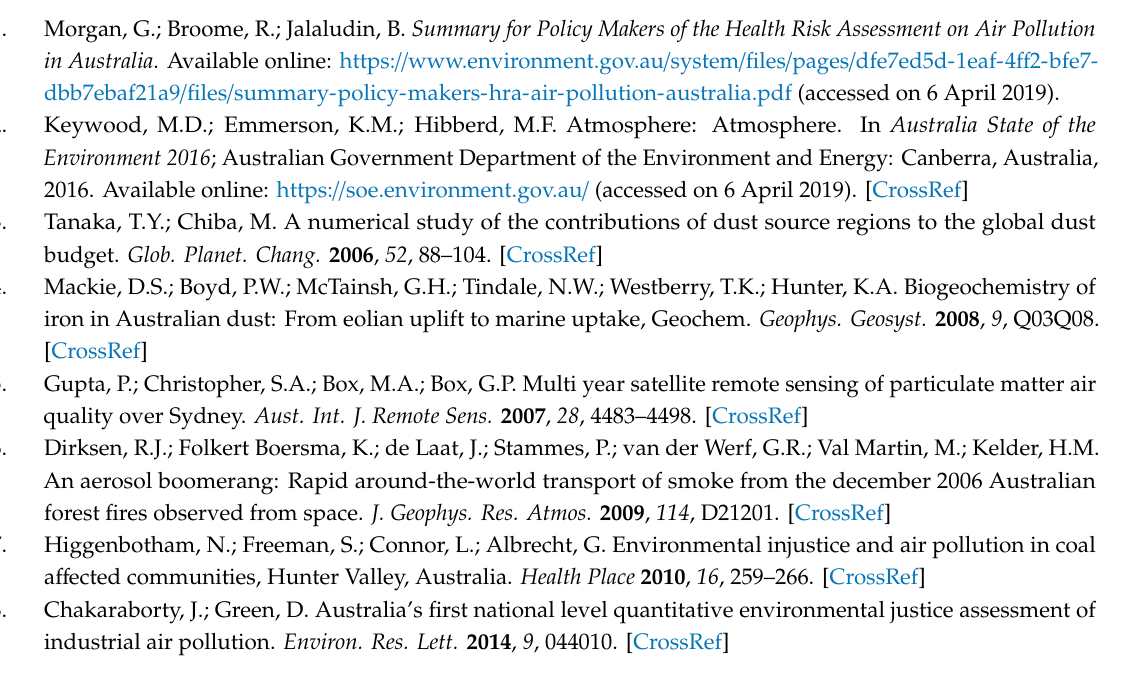
Figure S1: Observed and simulated temporal profiles of temperature at 2-m at selected sites during SPS1, SPS2, and MUMBA. All simulation results are based on WRF / Chem-ROMS. No observations are available at Bellambi during SPS2 and MUMBA. Figure S2: Observed and simulated temporal profiles of wind speed at 10-m at selected sites during SPS1, SPS2, and MUMBA. All simulation results are based on WRF / Chem-ROMS. No observations are available at Bellambi during SPS2 and MUMBA. Figure S3: Observed and simulated temporal profiles of precipitation at selected sites during SPS1, SPS2, and MUMBA. All simulation results are based on WRF / Chem-ROMS. Figure S4: Observed and simulated temporal profiles of O 3 concentrations at selected sites during SPS1. All simulation results are based on WRF / Chem-ROMS. Figure S5: Observed and simulated temporal profiles of O 3 concentrations at selected sites during SPS2. All simulation results are based on WRF / Chem-ROMS. Figure S6: Observed and simulated radiation and optical variables and CCN over southeastern Australia (d02) during SPS2 and MUMBA. The simulation results are from WRF / Chem-ROMS. Figure S7: Observed and simulated cloud variables over southeastern Australia (d02) during SPS2 and MUMBA. The simulation results are from WRF / Chem-ROMS. Table S1: Statistics of O 3 for WRF / Chem-ROMS v3.7.1 simulations (81-km, 27-km, 9-km, and 3-km) over nine individual sites with 3-km domain. Table S2: Statistics of PM 2.5 for WRF / Chem-ROMS